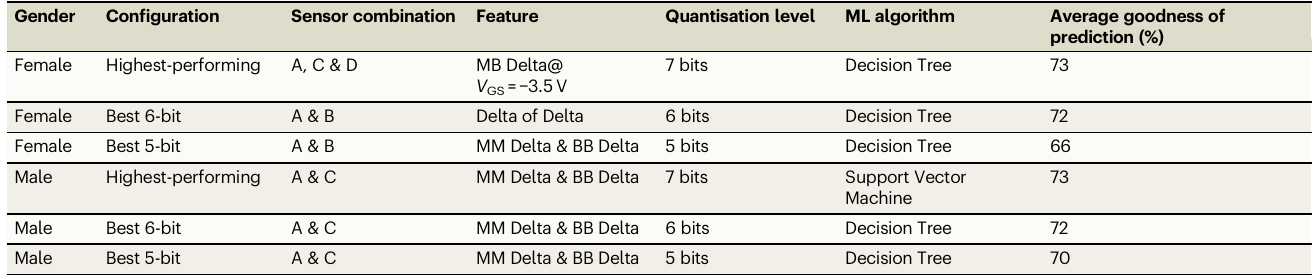
Table 1 | Average goodness of prediction